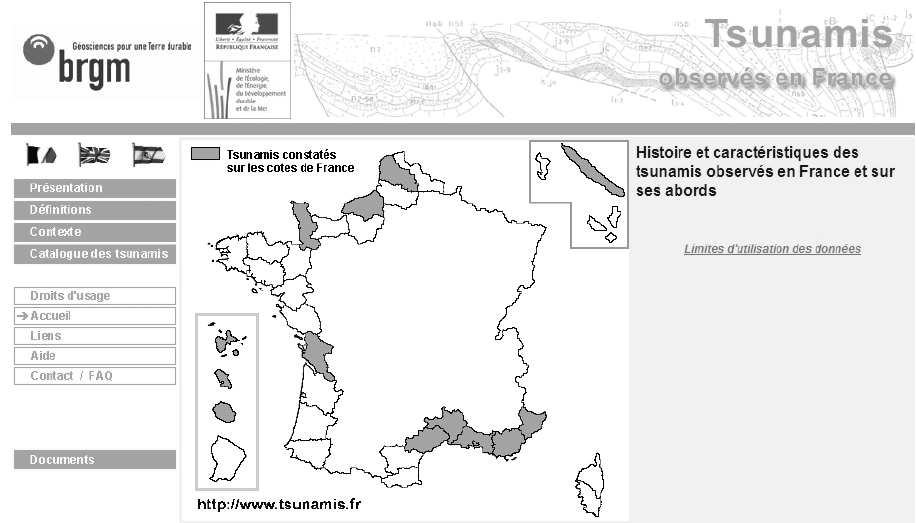
Fig. 1 – Home page of the www.tsunamis.fr website Fig. 1. Home page of the www.tsunamis.fr